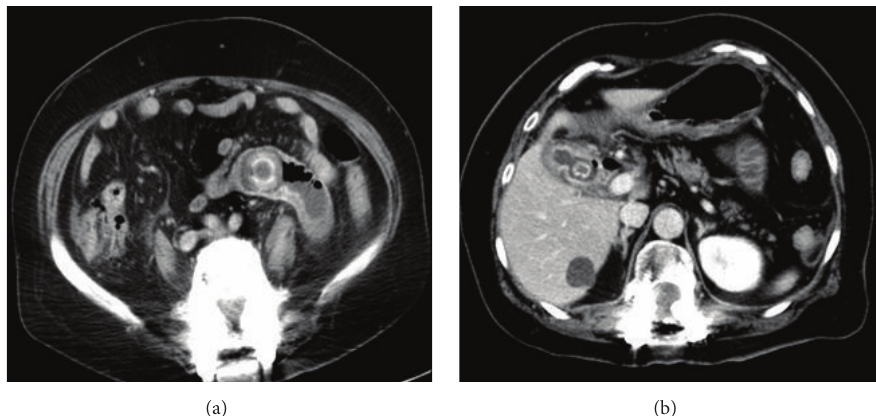
Figure 1: Computed tomography (CT) images showing (a) small bowel obstruction by a partially calcified object in the jejunum and (b) inflammation around the gallbladder, with a gallstone, and thickening between the gallbladder and the duodenal walls. Air-fluid levels in the gallbladder were also seen.